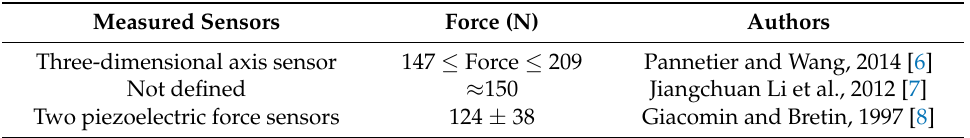
Table 1. Comparison of the applied force on the clutch pedal between different authors.